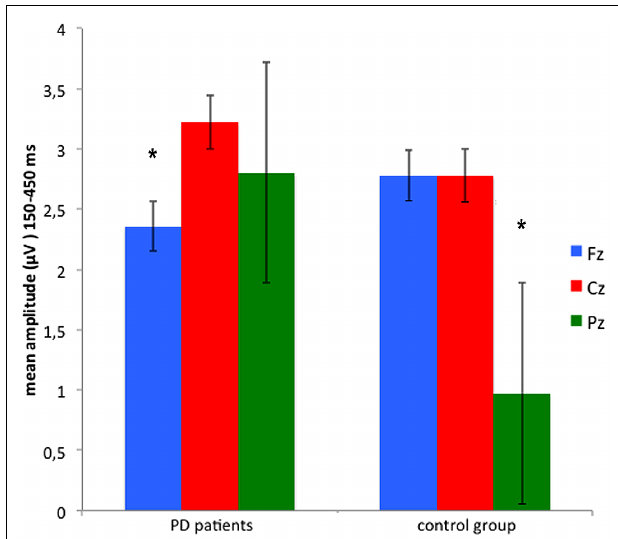
FIGURE 3 | Mean amplitude recorded in the time window between 150 and 450 ms from anterior (Fz) central (Cz) and parietal (Pz) sites. *Significant difference refers to a p value < 0.05. Error bars represent standard